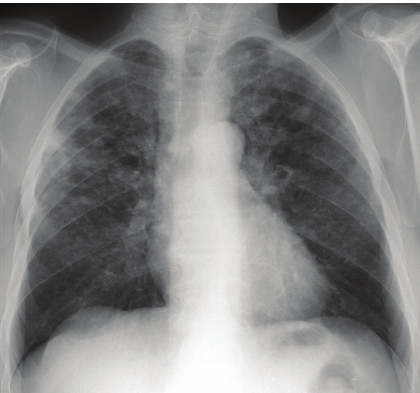
Figure 4: Axial contrast-enhanced abdominal CT: the patient presented increased liver dimension (hepatomegaly) in a biopsy provenliveracuteinvolvementofLCH.Multiplehypodensenodules are identified, some of which confluent. No bile duct dilatation is present.